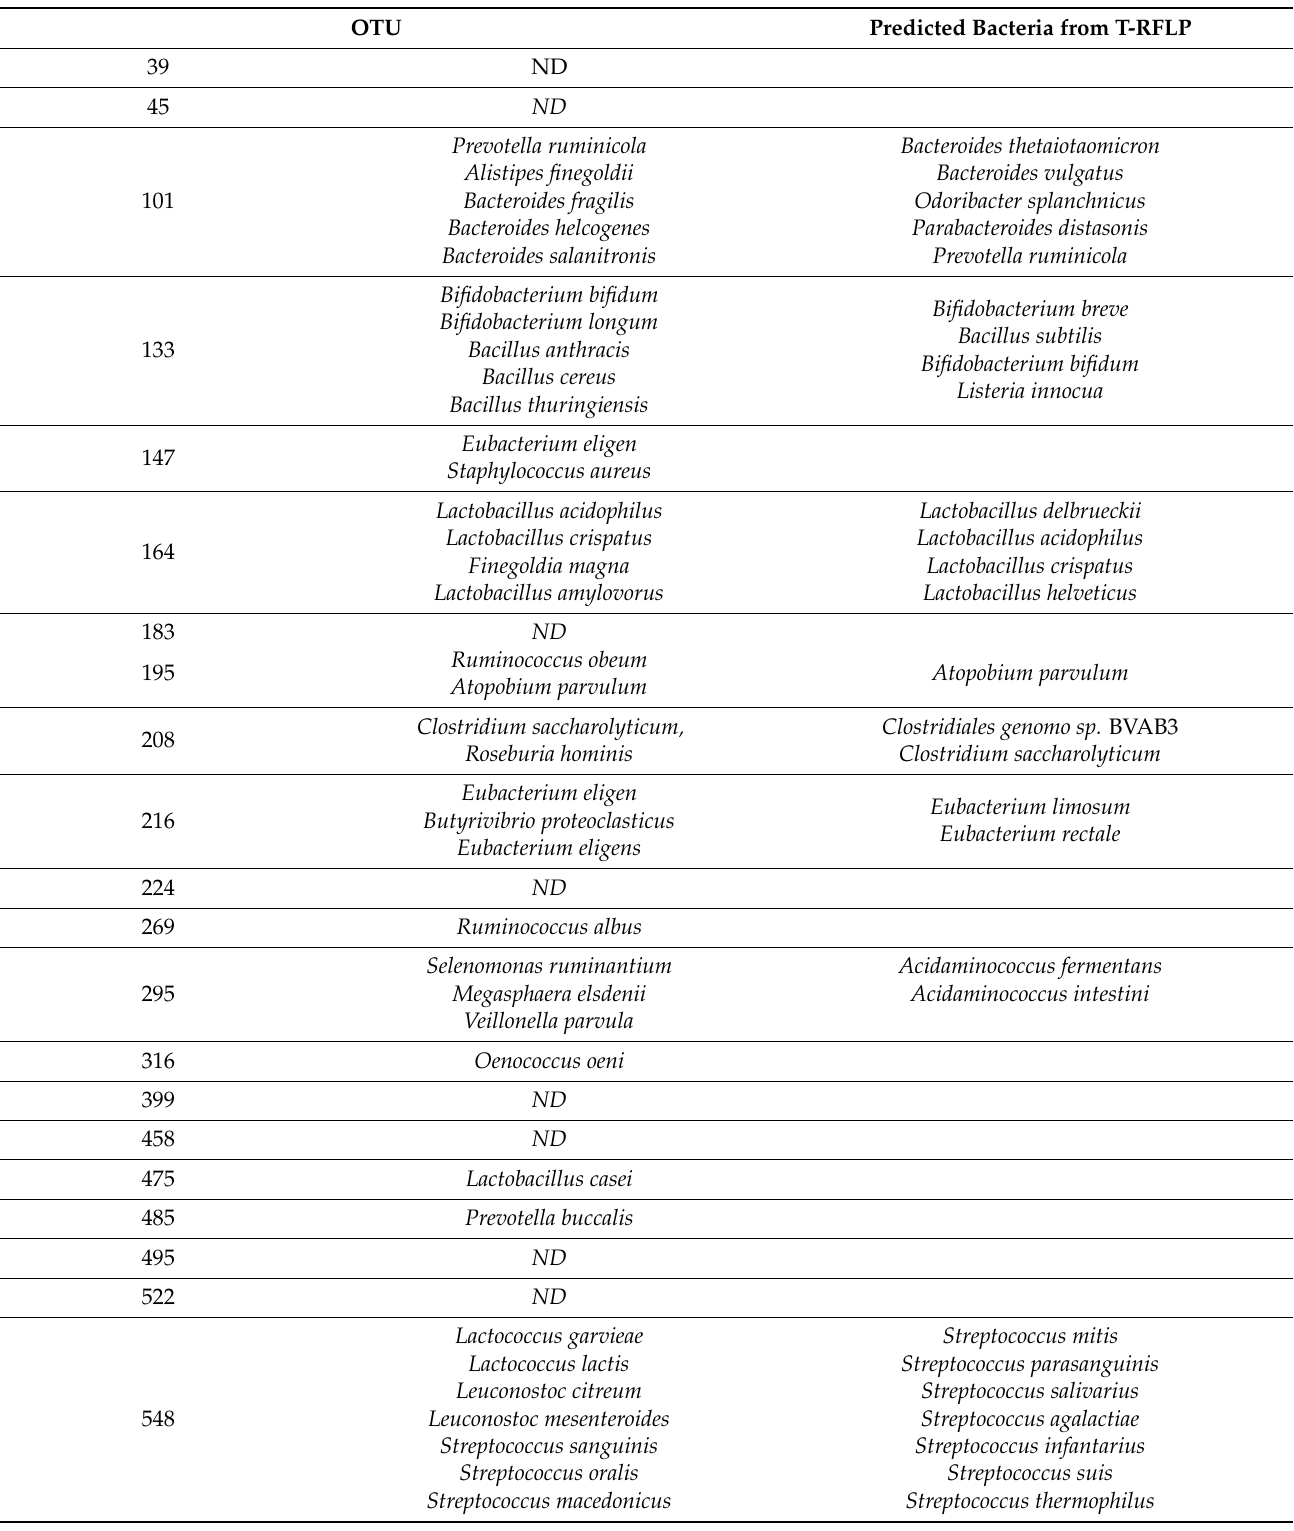
Table 3. Correspondence of OTUs to the bacteria predicted by means of theoretical digestion with the restriction endonuclease,